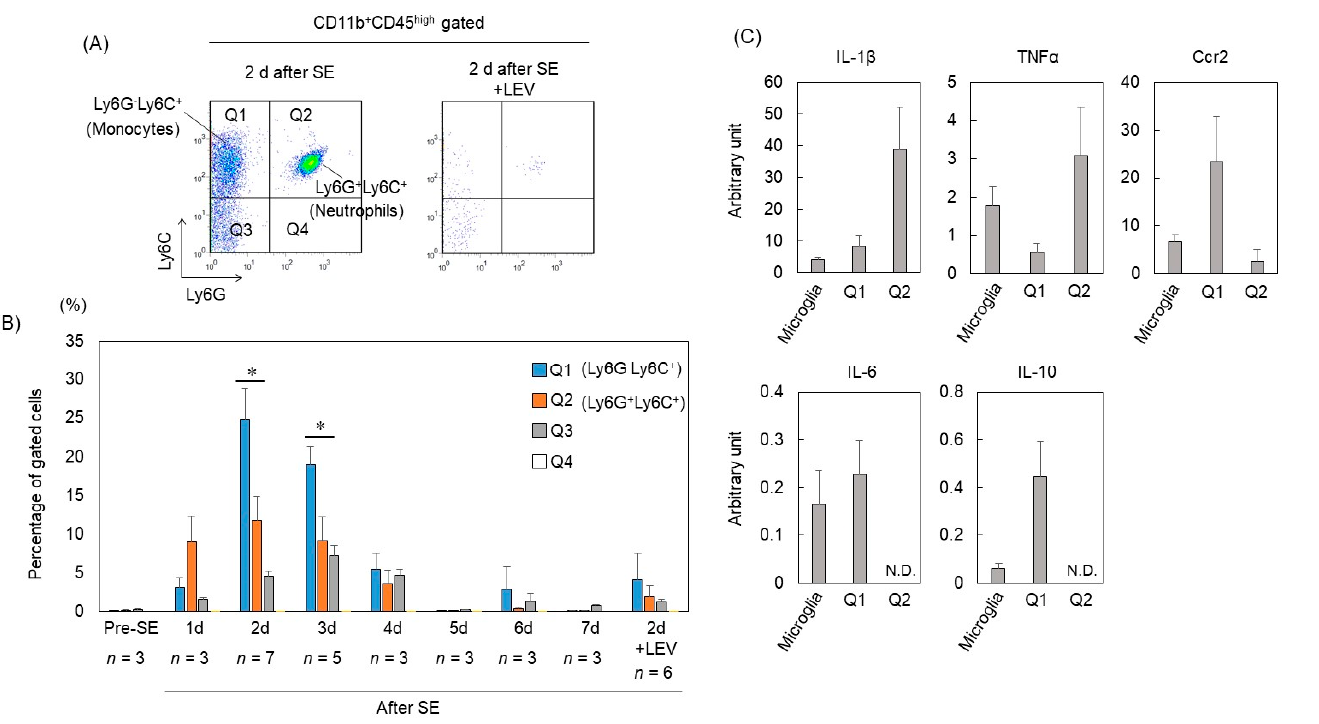
Figure 2. Characterization of CD11b + CD45 high brain-infiltrating leukocytes. ( A ) Flow cytometry analysis of CD11b + CD45 high fractions 2 d after SE. As shown in Figure 1, debris, doublets and dead cells were excluded. Live cells were subgated on CD11b + CD45 high cells. Ly6C/Ly6G immunoreactivity was used to distinguish neutrophils and monocytes. The results are representative of at least 3 independent experiments. ( B ) Changes as a function of time in the percentage of cells in the Q1, Q2, Q3 and Q4 fractions within the PI − population defined by flow cytometry analysis. n indicates the number of independent experiments. Data are means ± SEMs. * p < 0.05, unpaired t test. ( C ) Mice were killed 2 days after pilocarpine-induced SE. mRNA was isolated from FACS-sorted CD11b + CD45 med (microglia), CD11b + CD45 high Q1 (monocytes) and CD11b + CD45 high Q2 (neutrophils) cells and measured by qRT–PCR. The expression of each gene was normalized to the expression of Actb. Number of samples: microglia, n = 5; Q1, n = 4; Q2, n = 4. Data are means ± SEMs. N.D., not detected.